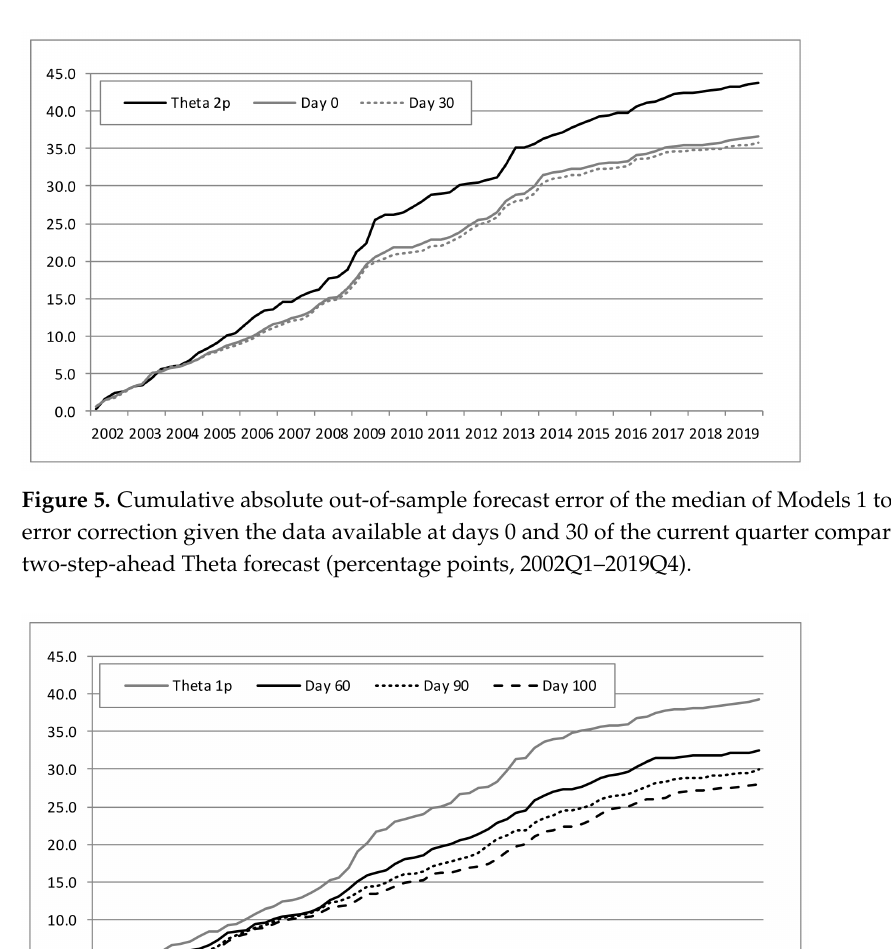
Figure 4. Cumulative absolute out-of-sample forecast error of the median of Models 1 to 6 given the data available at days 0 and 30 of the current quarter compared with the two-step-ahead Theta forecast (percentage points, 2002Q1–2019Q4).